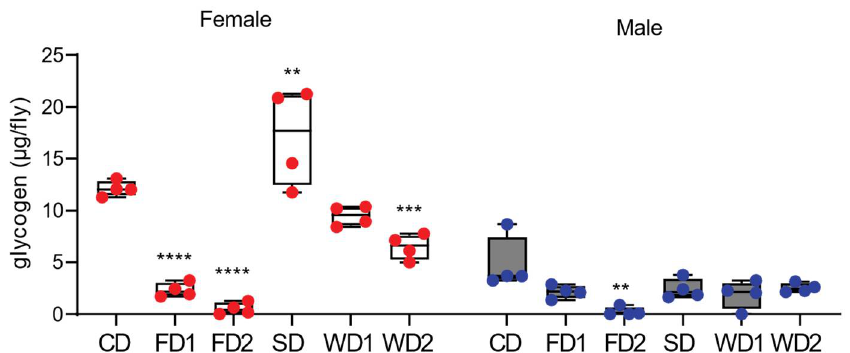
Figure 3. Glycogen levels in adult male and female flies exposed to diets supplemented with sugar, fat, or a combination of sugar and fat. The glycogen levels in adult male and female Dahomey flies exposed to the normal diet (CD), fat (coconut oil)-supplemented diet (FD1 and FD2), (sucrose) sugar-supplemented diet (SD), and western diets (WD1 and WD2). Glycogen levels are expressed as µg per fly in females and males. Box plots display the median values, and whisker plots indicate the minimum and maximum values. The diets supplemented with fat decreased the glycogen contents in females and males. The addition of sugar to the diet increased the glycogen content only in females. p -values were determined using two-way ANOVA main effects as following: diet, p < 0.0001; sex, p < 0.0001 and their interaction; p < 0.0001 with a Dunnett’s multiple comparison test comparing the data on the diets to those on the CD per sex. ** p < 0.005, *** p < 0.0005, **** p < 0.0001.